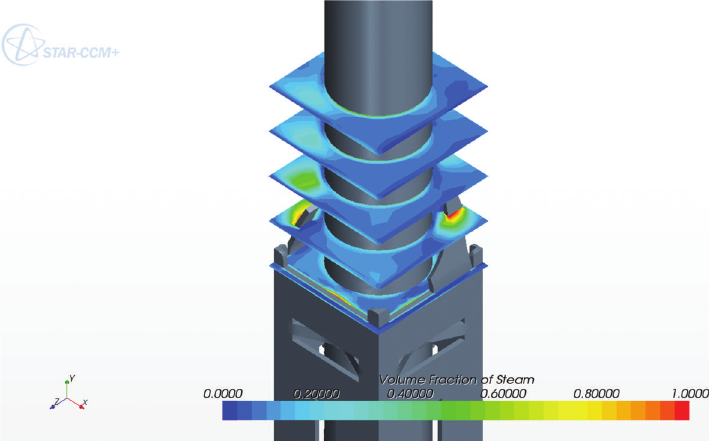
Figure 10: Void distribution above mixing vane spacer around one rod.